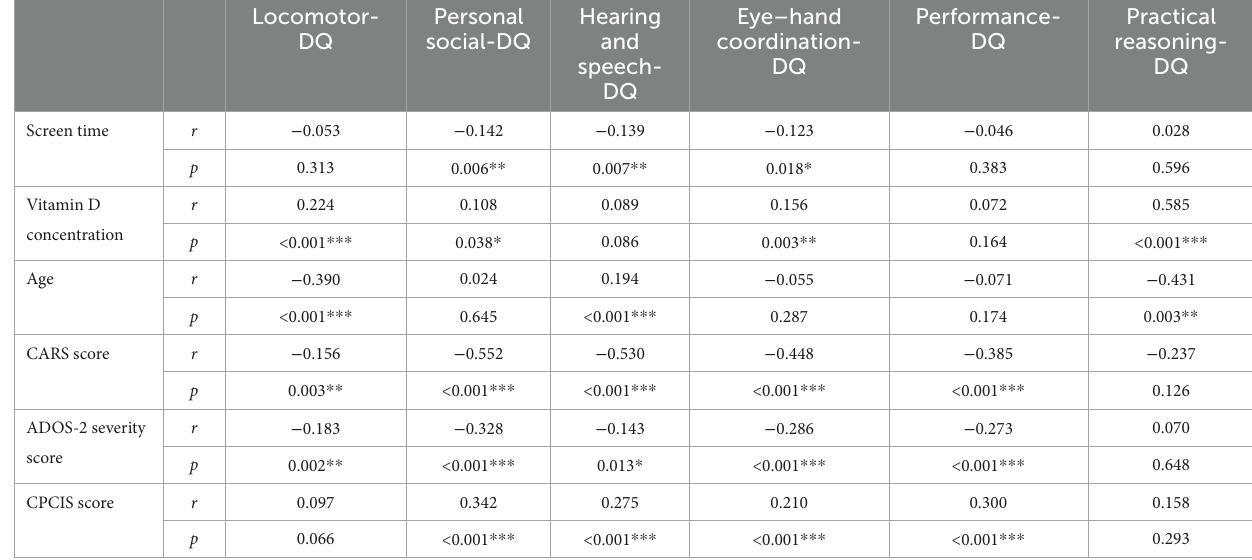
TABLE 2 Correlations among screen time, vitamin D concentration, age, CARS scores, ADOS-2 severity scores, CPCIS scores and DQ scores.